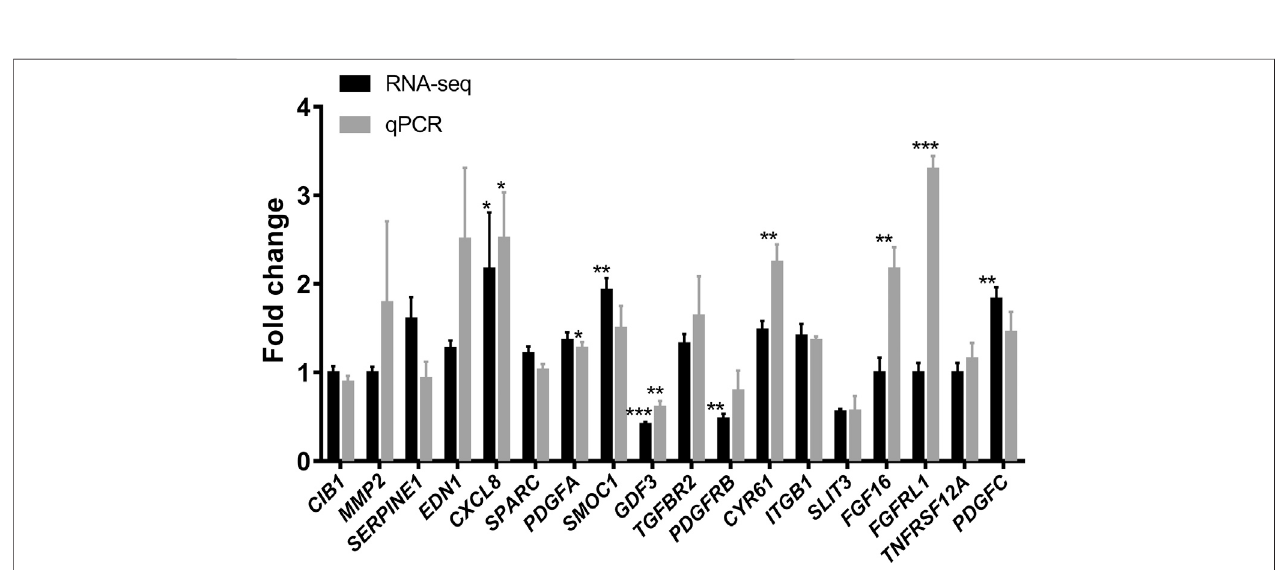
FIGURE 6| Elevation ofmRNA expression in HUVECs treated with the combination ofginsenoside Rb2 (50 μ M) and ginsenoside Rg3 (5 μ M) or vehicle for 72 h as determined by real time qPCR (in gray) and compared to RNA-Seq data (in black). It can be seen that the Rb2/Rg3 combination upregulated several genes by 2- to 3- fold, such as CXCL8, CYR61, FGF16 and FGFRL1 . Data represents mean ± SD of four replicates. * p < 0.05, ** p < 0.01, *** p < 0.001.